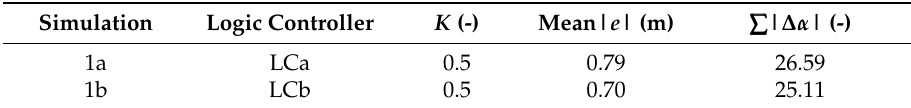
Table 1. Results of simulations 1a and 1b related to scenario 1 (control valve), in terms of mean |e|